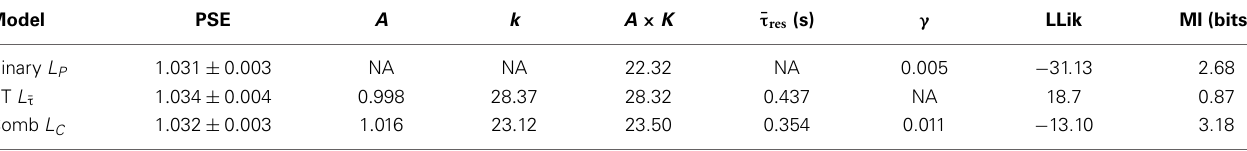
Table 1 | Results for three